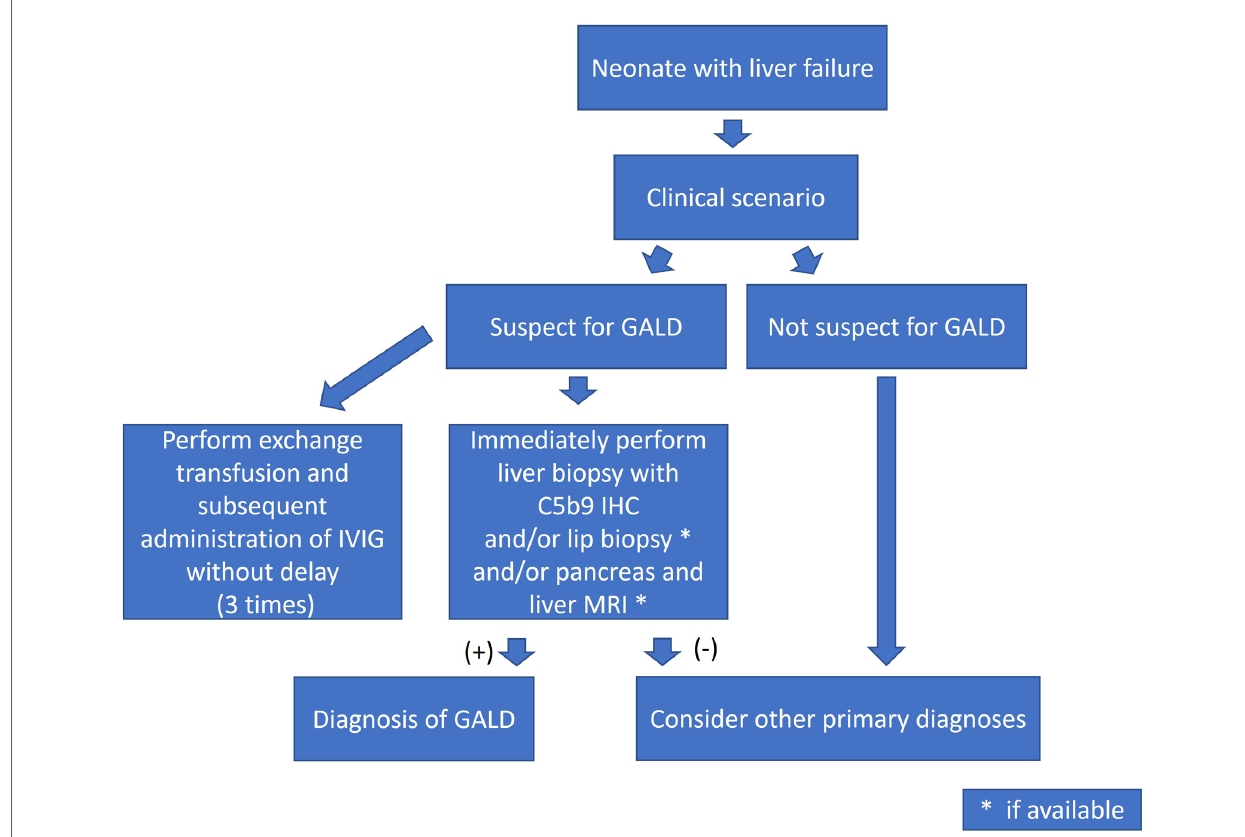
FIGURE 3 Flow-chart, Erlangen; IVIG, intravenous immunoglobulins, MRI, magnetic resonance imaging, GALD, gestational alloimmune disease, IHC,